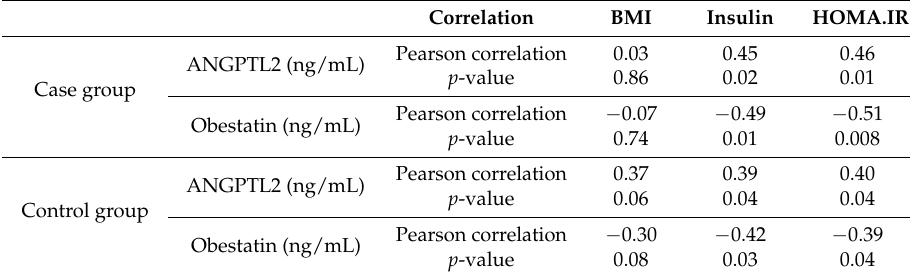
FBS: Fasting blood sugar; HDL-C: High-density lipoprotein cholesterol; LDL-C: Low-density lipoprotein cholesterol; LH: Luteinizing hormone; FSH: Follicle stimulation hormone; DHEAS: Dehydroepiandrosterone-sufate; Cr: Creatinine. Table 3. The correlation between ANGPTL2 and obestatin with other variables in case and control